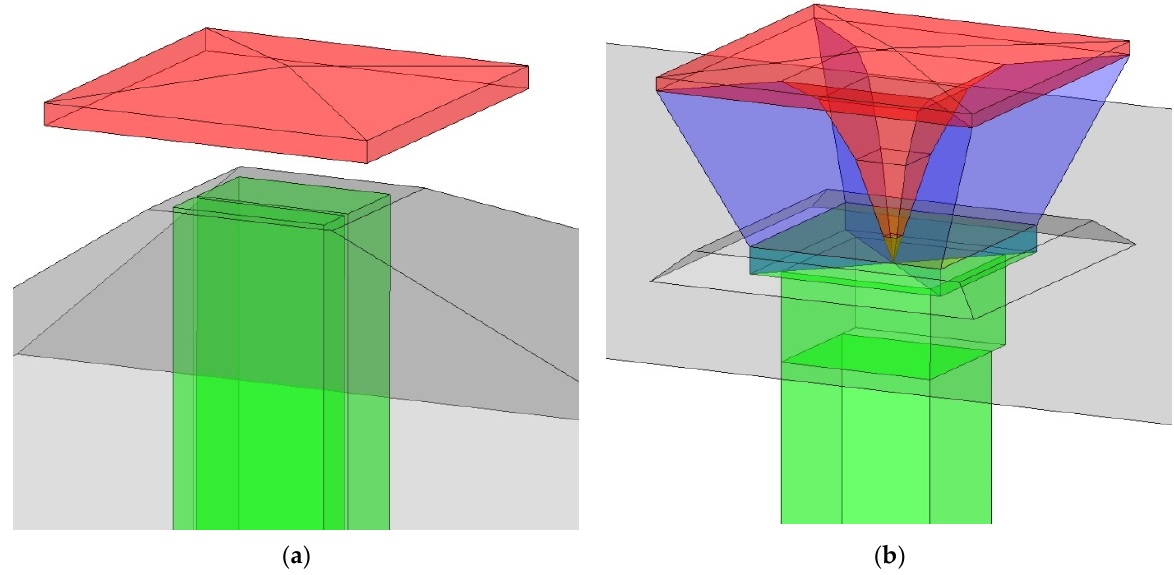
Figure 5. ( a ) ‘Venturi’ plate structure (red) as deflector of the outlet tower (green) with lifting (closing) mechanism; ( b ) Omnidirectional chimney crown geometry (red) on top of the inlet tower (green) with diaphragm deflectors on diagonals (blue).